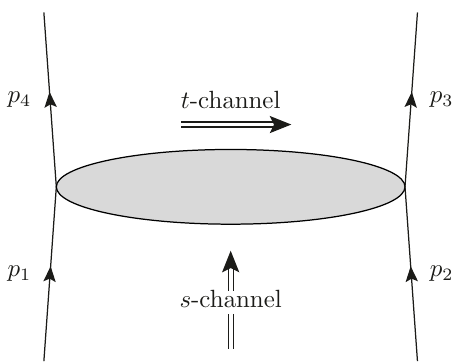
Figure 1 . The t -channel exchange dominating the high-energy limit, s de(cid:12)nes our conventions for momenta assignment and Mandelstam invariants. We shall assume that particles 2 and 3 (1 and 4) are of the same type and have the same